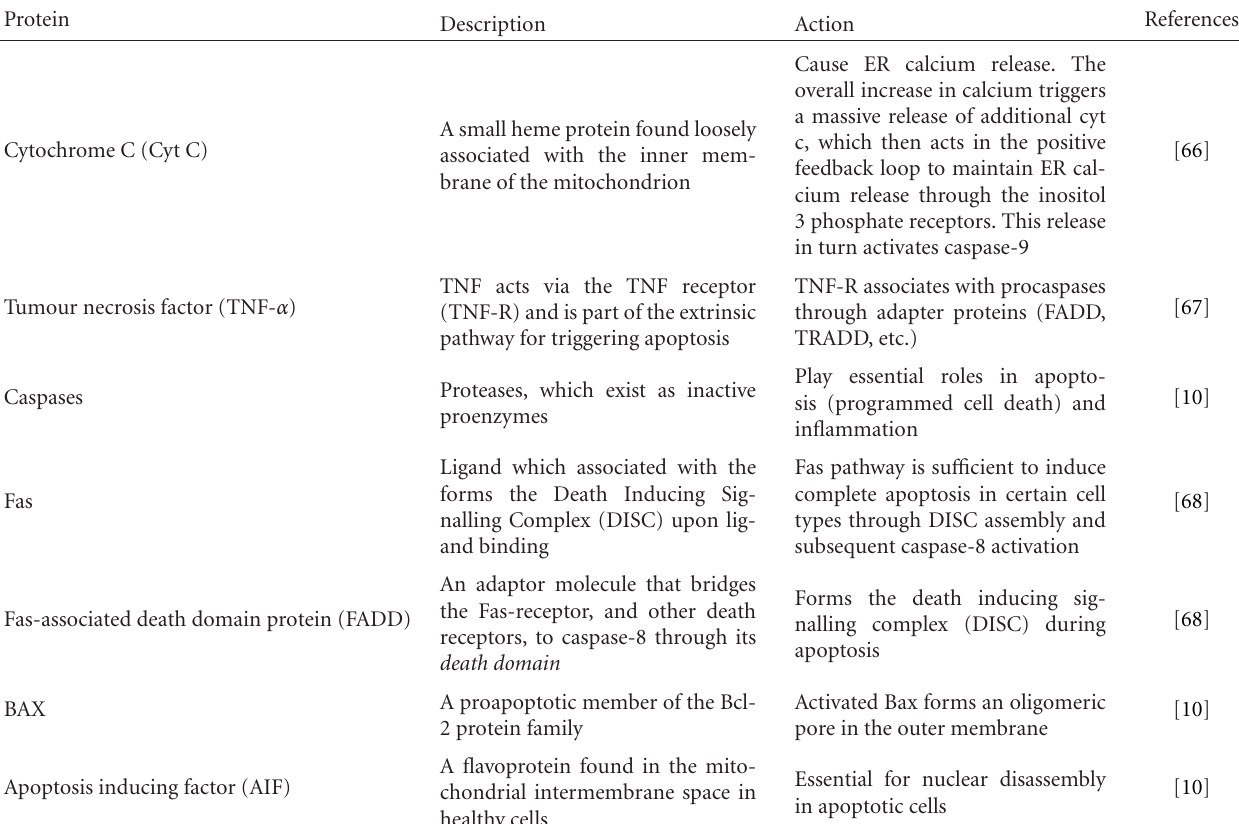
Table 3: Poteins associated with the apoptotic pathway could potentially be discovered in the CSF after cell death. The levels of these proteins can be expected to increase during pneumococcal meningitis as a result of both the inflammatory response and the release of pneumococcal